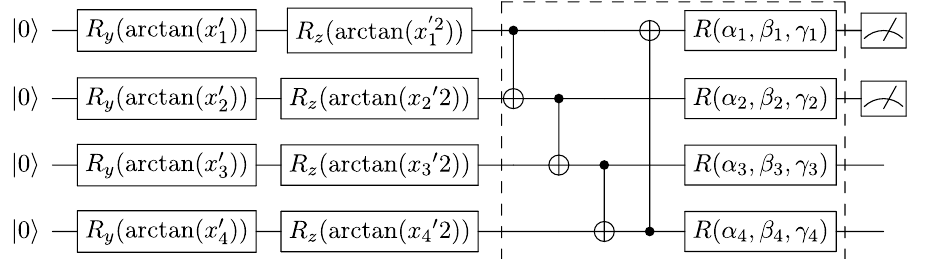
Figure 12. Second quantum circuit block for MNIST classification. The second subcircuit uses variational encoding to encode the output from the first block to be the input for this subcircuit. α ′ i , β ′ i , and γ ′ i are the parameters to optimize. The dashed box denotes one block of a quantum circuit that is repeated four times. There are 12 × 4 = 48 parameters to the circuit block. The dial to the far right represents that the circuit has four outputs, and the expectation of σ z is measured on two qubits. In the context of cross-entropy, the outputs will be interpreted as the probability that the image is of a ‘0’ or a ‘1,’